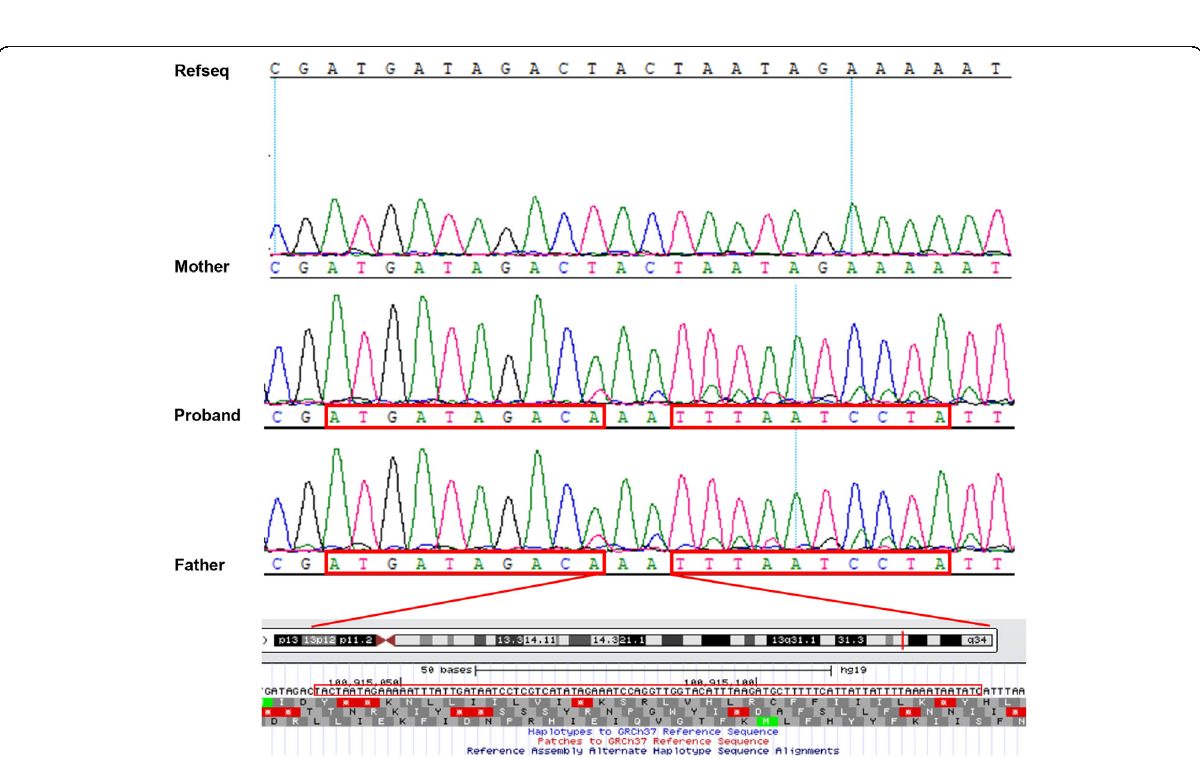
Fig. 2 The delins c.773_819 + 47delinsAA mutation detected in the family using Sanger sequencing. The proband and his father are heterozygous, while the mother is the same as the reference sequence. The red box shows the breakpoint